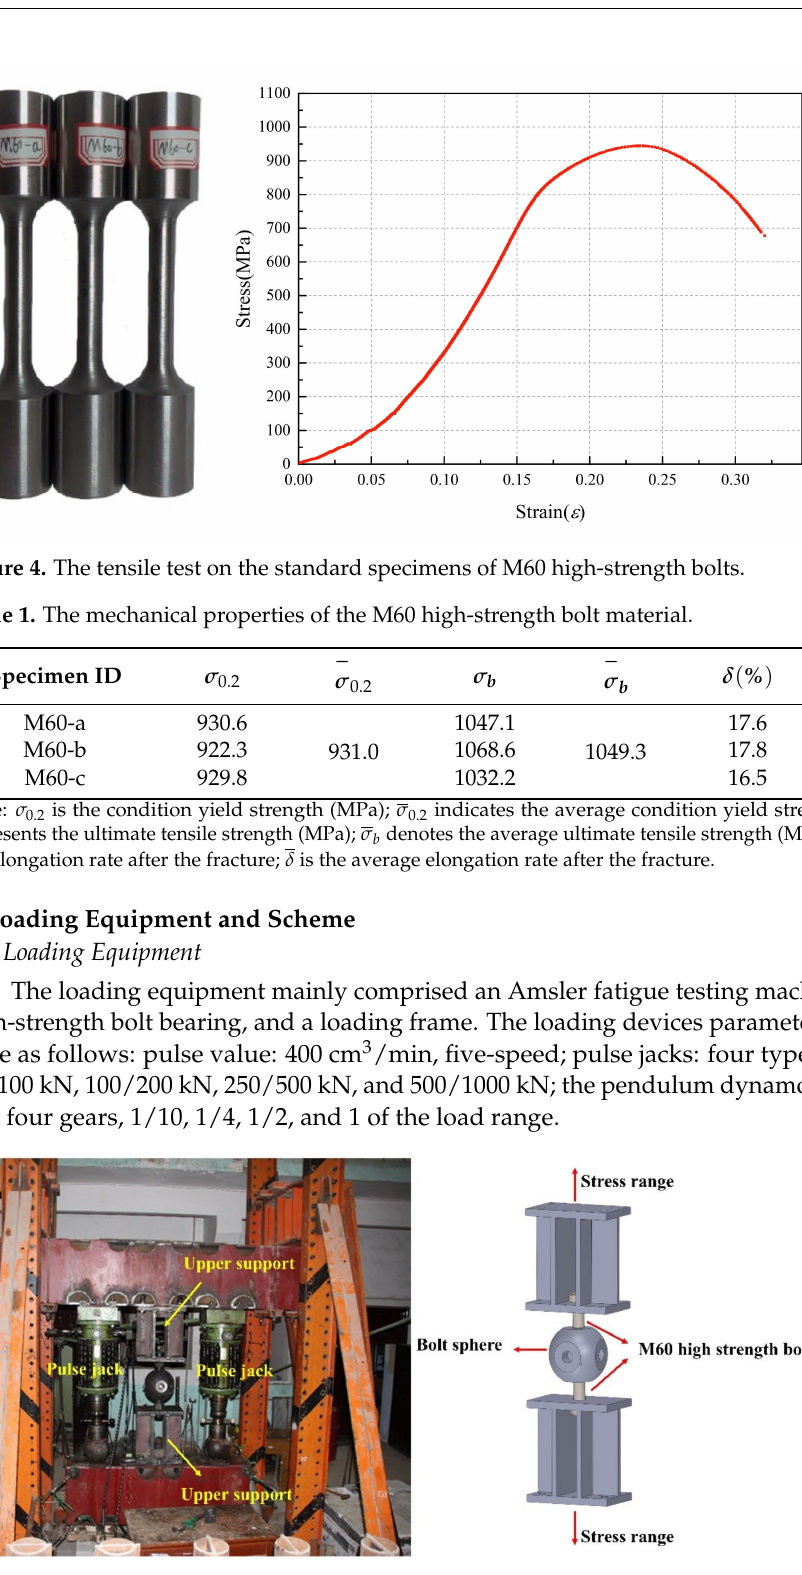
Figure 5. A general view of the fatigue loading of the bolted spherical joint. The loading frame was connected with the upper and lower box-shaped steel